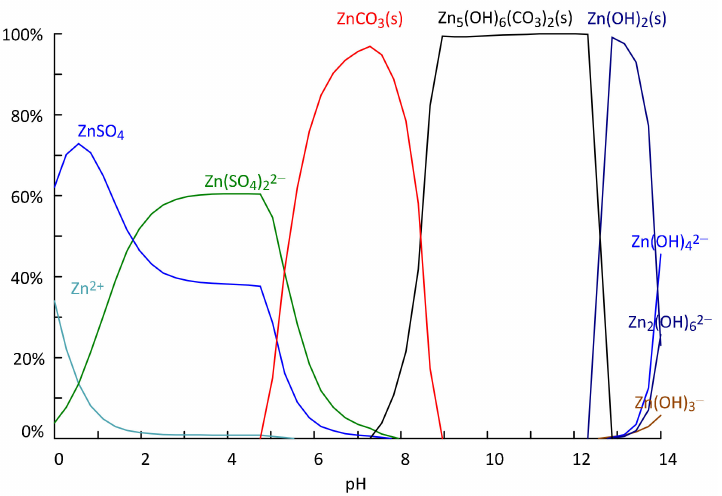
Figure 13. Fraction diagram of [ZnCO 3 ] = 0.310 M precipitation with [Na 2 CO 3 ] = 0.310